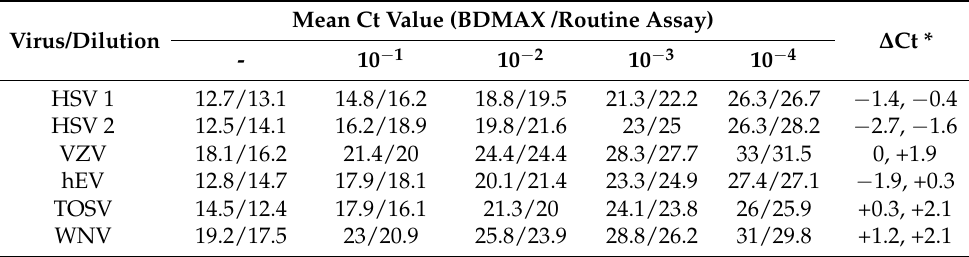
Mean Ct Value (BDMAX /Routine Assay)